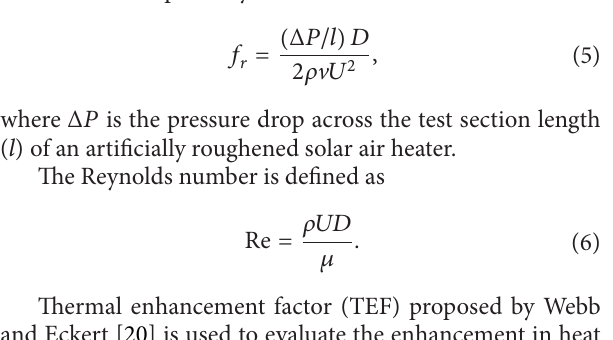
Table 3: Thermophysical properties of air and absorber plate for CFD